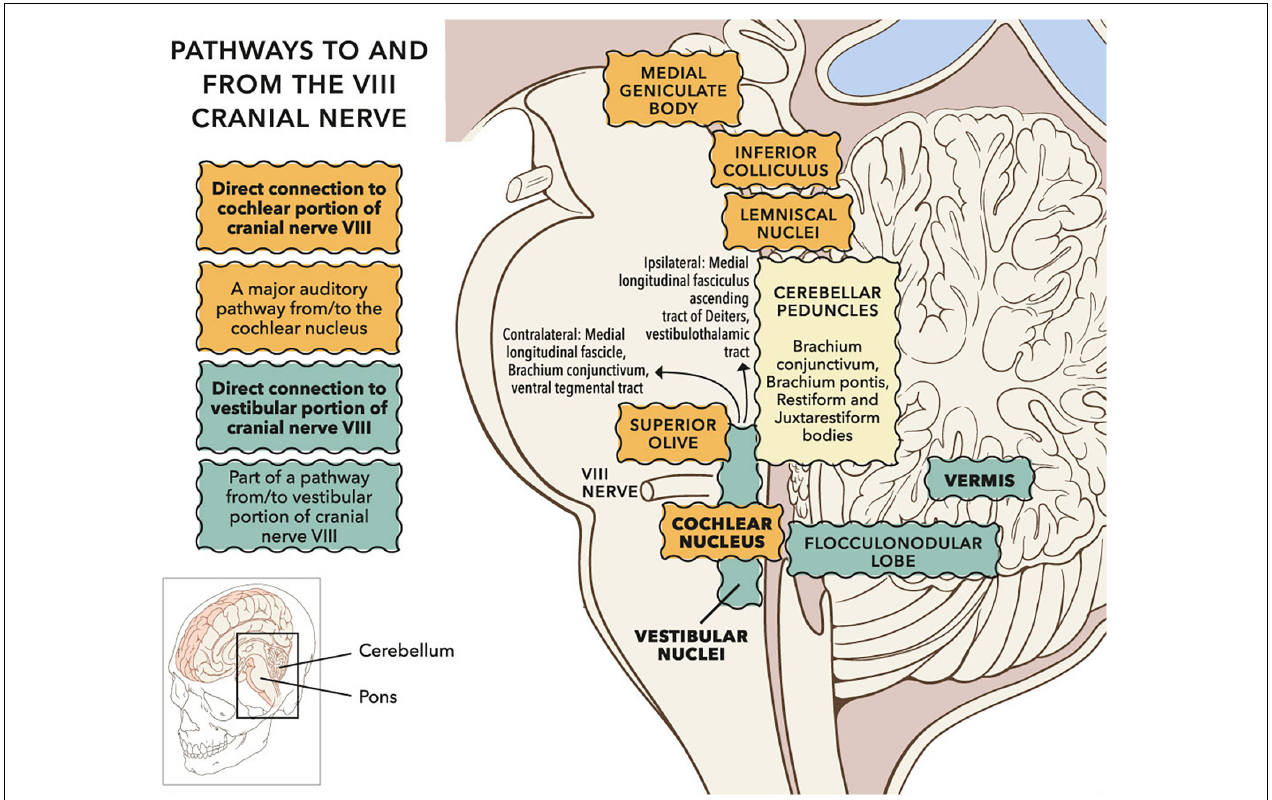
FIGURE 14 | Sagittal view of subcortical pathways to and from the VIII cranial nerve. Whilst the auditory pathway ascending from the cochlear nucleus is relatively well established (Irvine, 1992), pathways to and from vestibular nuclei remain under investigation (Pierrot-Deseilligny and Tilikete, 2008; Zwergal et al., 2009). Projections to vestibular cortex via the thalamus have been investigated in humans through clinical observation and lesion studies (Conrad et al., 2014; Hitier et al., 2014; Wijesinghe et al., 2015). Vestibular nuclei also project down the spine (not shown). © Portions of this figure were adapted from illustrations by Patrick J. Lynch, http://patricklynch.net/. Creative Commons 2.5